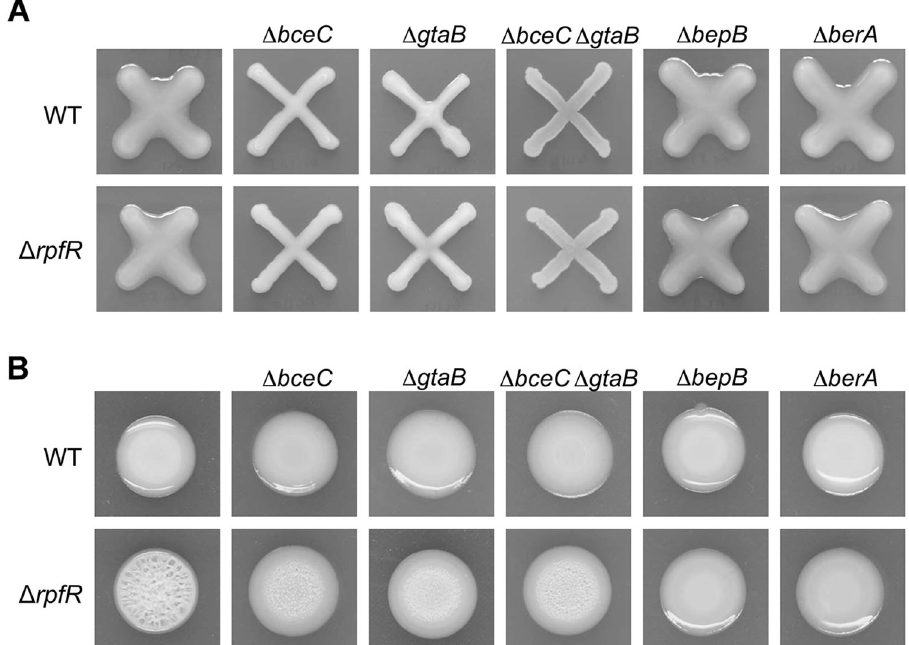
Fig. 2 Assessment of cepacian production and role of cepacian and Bep in colony morphology. A Assessment of cepacian production of wild-type and mutant strains after growth on YEM agar plates for 2 days. Cepacian production appears as slime surrounding the cross- colonies of the bacteria that are not mutated in the bceC or gtaB genes. B Role of cepacian and Bep in colony morphology of wild-type and rpfR mutants. Candidate EPS gene clusters were inactivated in the wild-type (upper panels) and the rpfR mutant background (lower panels). The Bep cluster was inactivated by deleting bepB ( Δ bepB ) or the BerA regulator ( Δ berA ). Cepacian production was reduced/abolished by deleting bceC ( Δ bceC ), gtaB ( Δ gtaB ) or both genes ( Δ bceC Δ gtaB ). Colony morphologies after growth on NYG agar plates for 6 days are